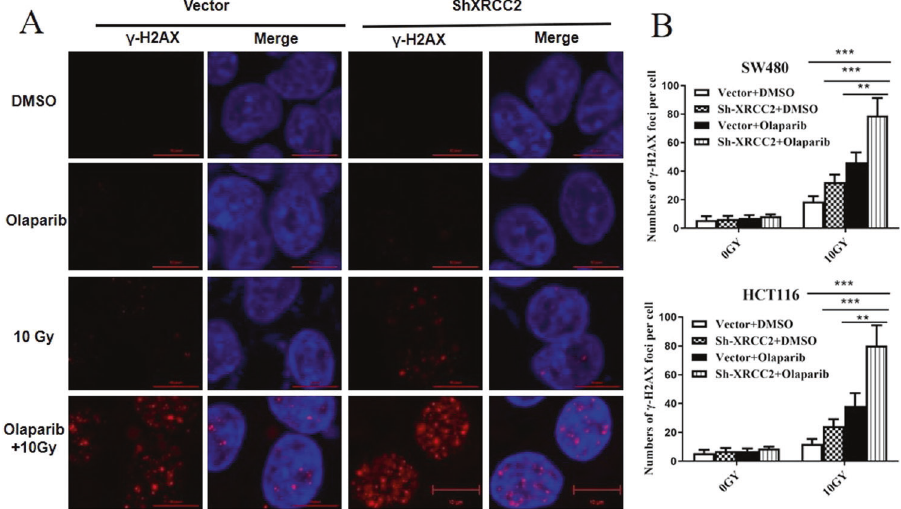
Fig. 3 Effect of olaparib on the persistence of radiation-induced double-strand breaks in XRCC2 -de fi cient rectal cancer cells. A Representative immuno fl uorescence images of γ -H2AX foci in SW480 cells at 48 h in the different treatment groups (×400). B Average number of γ -H2AX foci per nucleus in the different treatment groups. Results show the means and standard errors of the means (SEMs) from three independent experiments. ** P < 0.01, *** P <